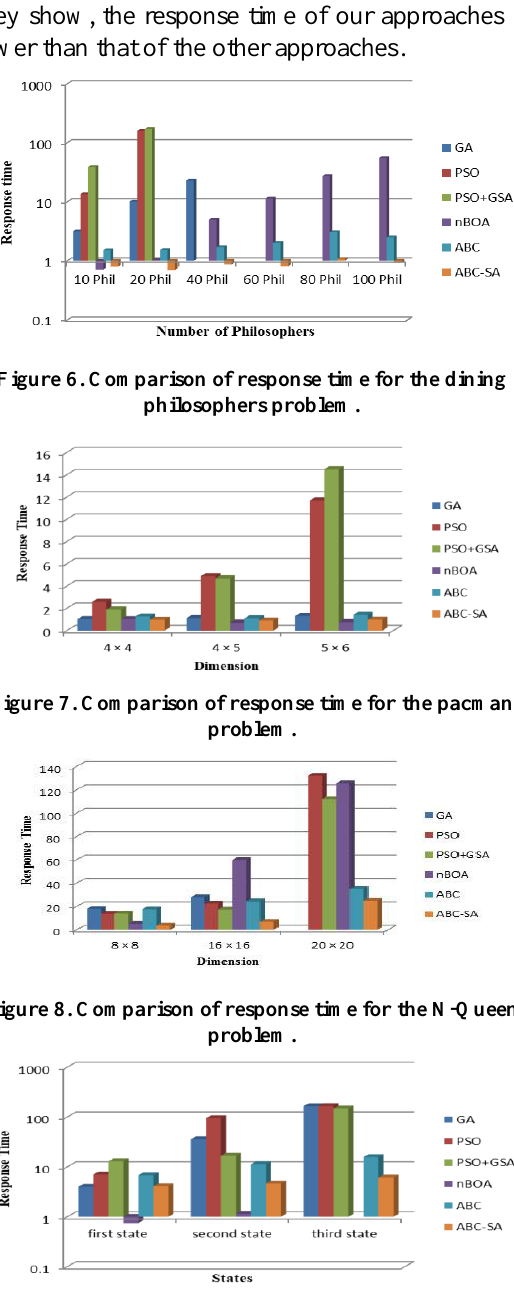
Figure 9. Comparison of response time for the 8-puzzle